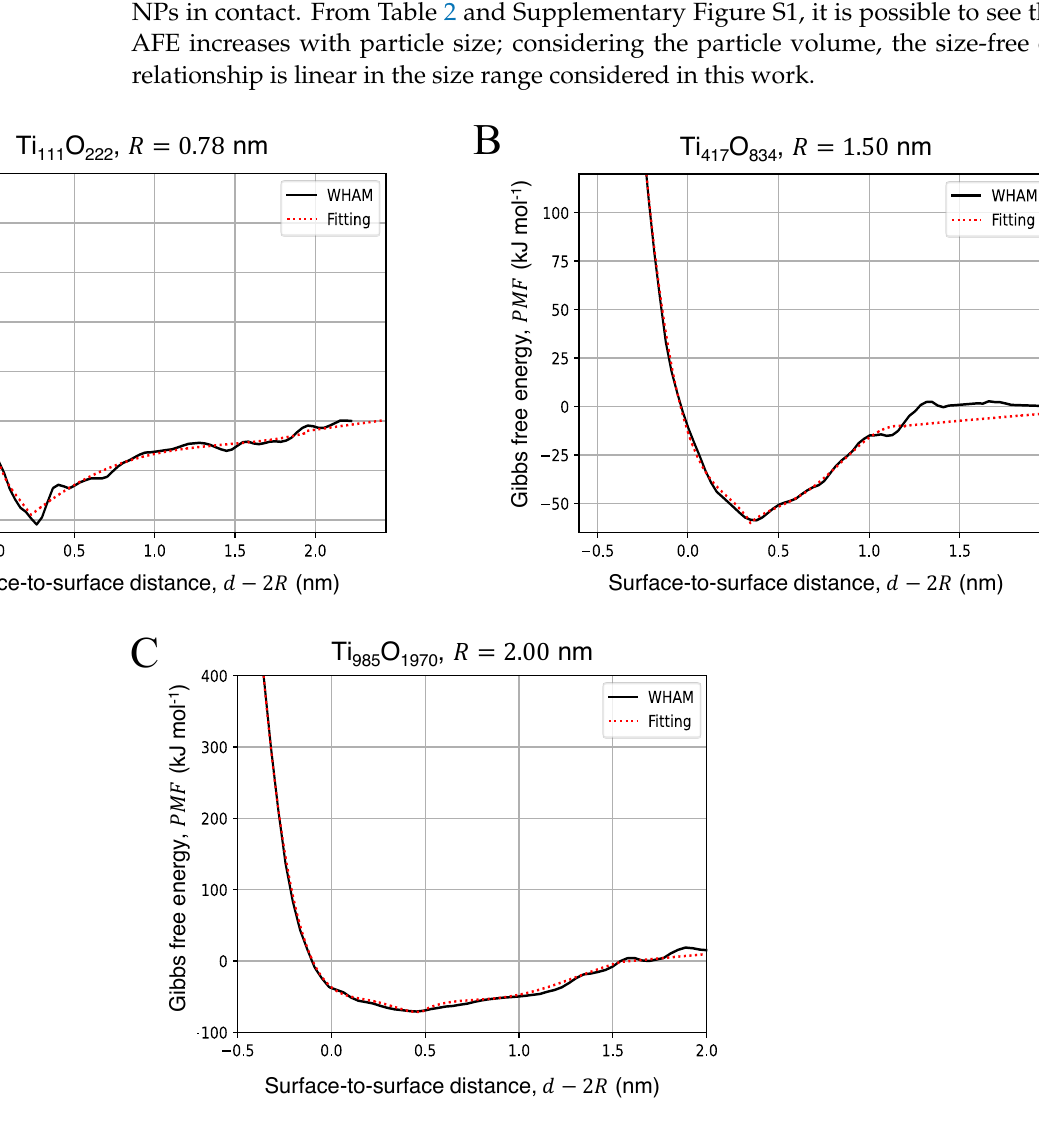
Figure 2. Free Energy profiles for the aggregation of two TiO NPs in water with chemical formula ( A ) 2 Ti O , ( B ) Ti O and ( C ) Ti O . The results of the MD simulations (solid black line) were 111 222 417 834 985 1970 fitted with Equation (1) (dotted red line) to produce the pair-wise tabled potentials. The PMFs and their respective fit curves were represented as down-shifted considering a null interaction at d → ∞